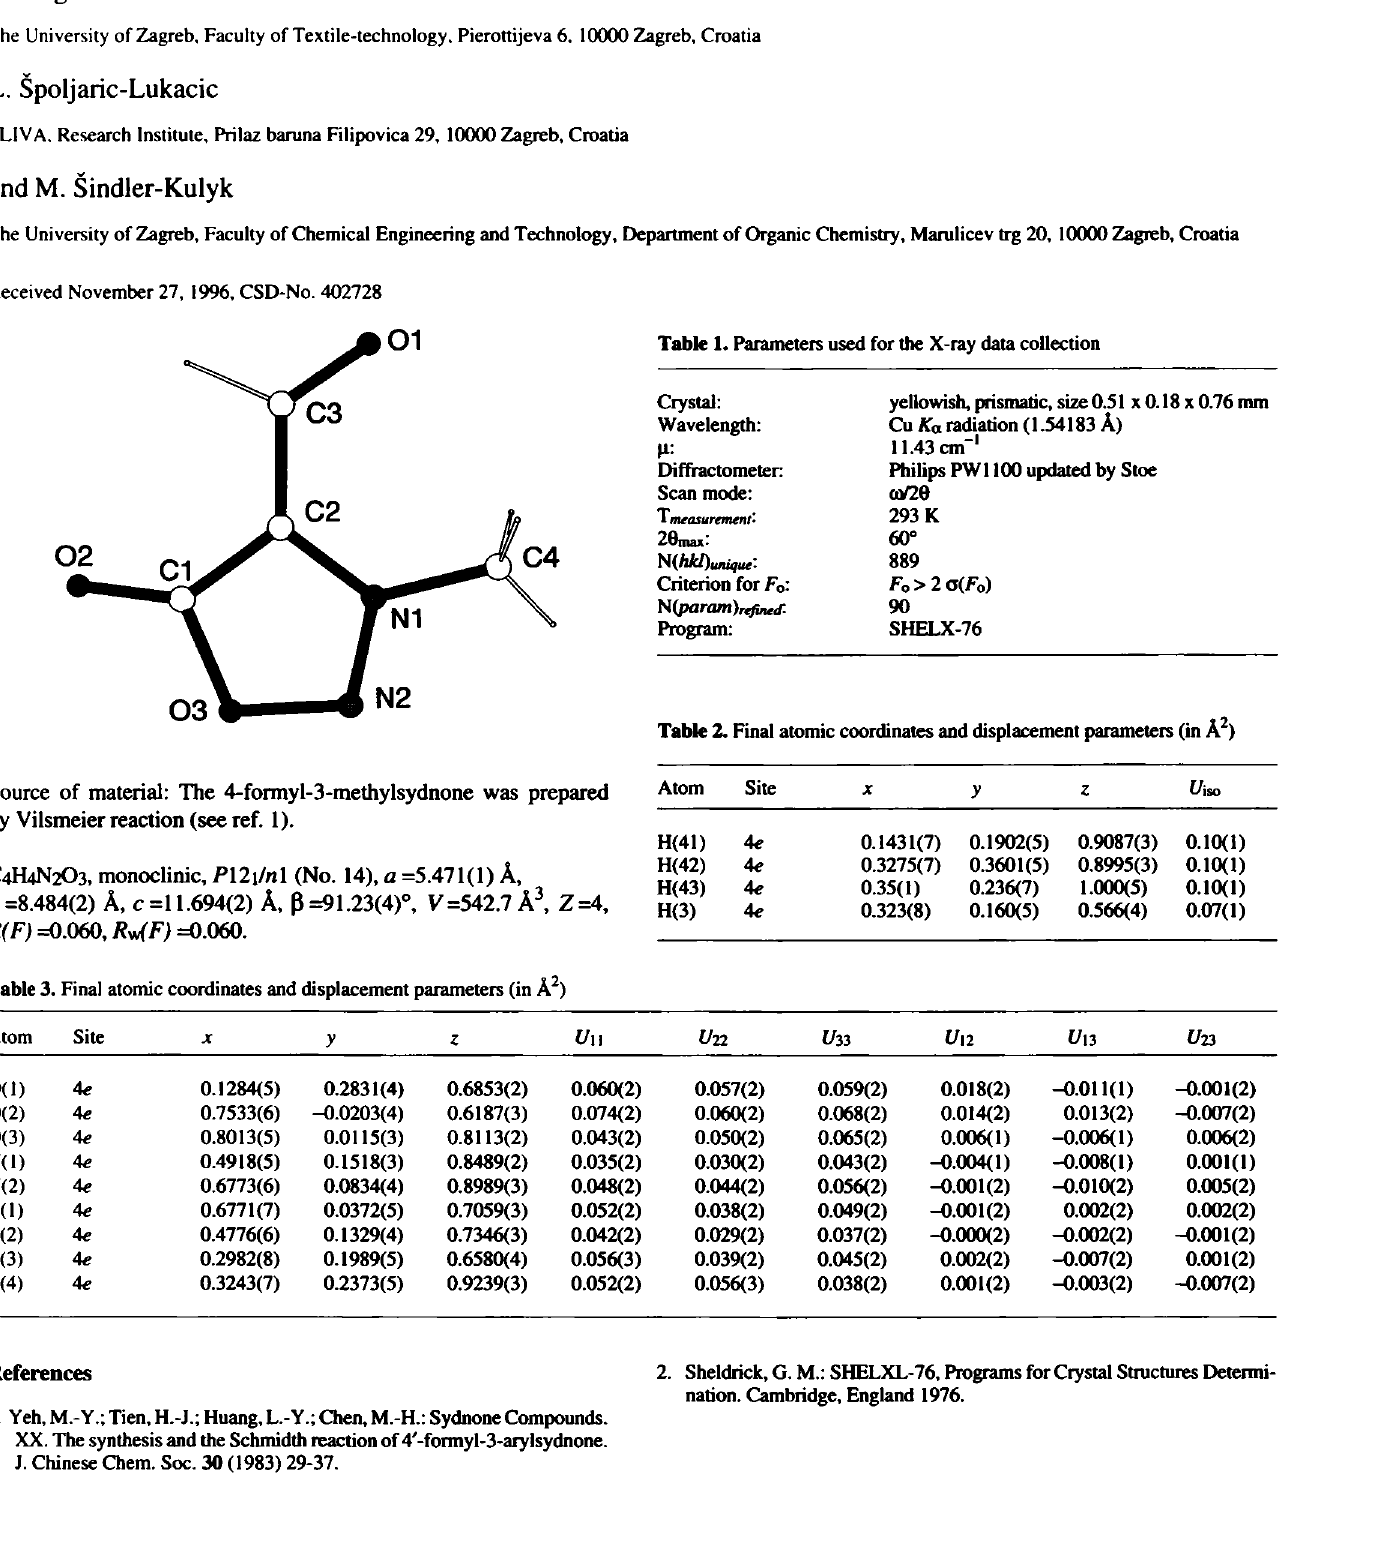
Table 2. Final atomic coordinates and displacement parameters (in Â 2